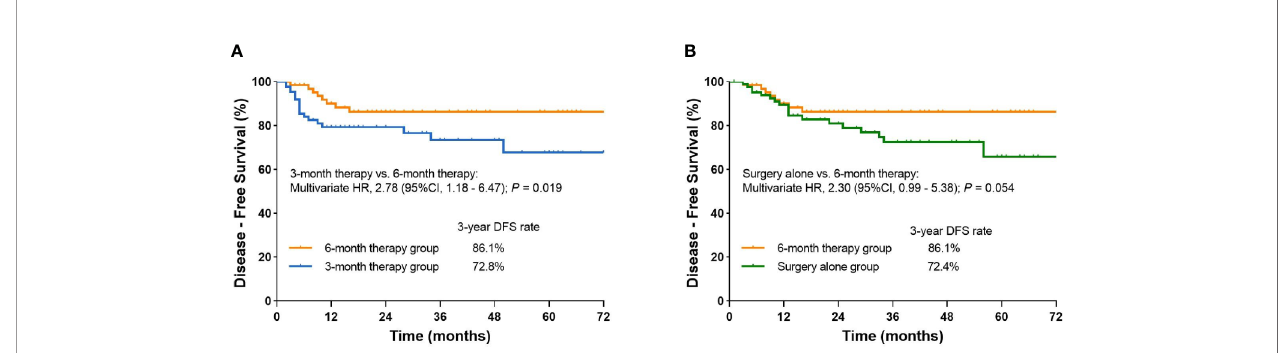
FIGURE 2 | (A) Kaplan-Meier curve of disease-free survival comparing 6-month therapy group and 3-month therapy group; (B) Kaplan-Meier curve of disease-free survival comparing 6-month therapy group and surgery